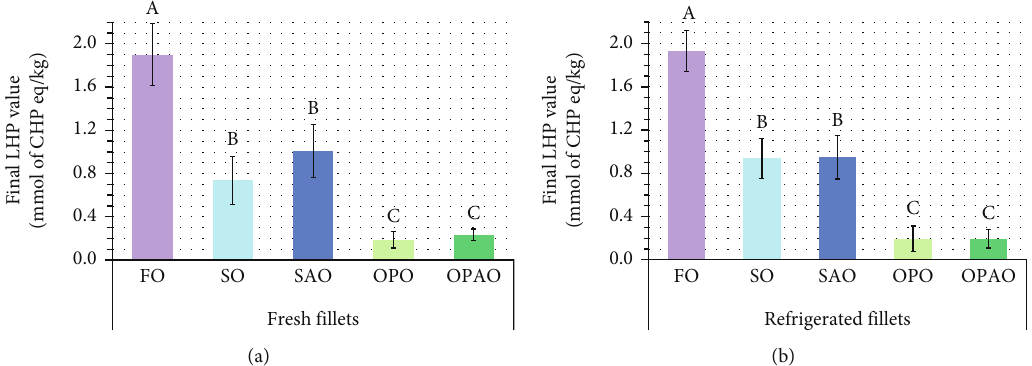
Figure 2: Oxidative stability: fi nal lipid hydroperoxide value obtained after an incubation time of 96h for fresh fi llets (a) and refrigerated fi llets (b) from the fi ve diets of interest. The results were represented as mean ± standard deviation ( n = 5 ) of CHP concentrations (mmol/kg). The di ff erences between dietary treatments found in fresh or refrigerated fi llets with Sche ff é ’ s post hoc test ( n = 25 ) were noted as A > B > C. Abbreviations: For diet abbreviations (FO, SO, SAO, OPO, and OPAO), see Table 2; LHP: lipid hydroperoxide; CHP: cumene hydroperoxide.